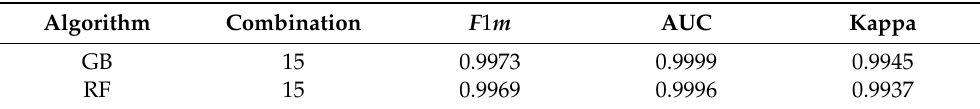
Table 6. Comparison metrics obtained for the GB and RF algorithms for the best combination in the dry season.